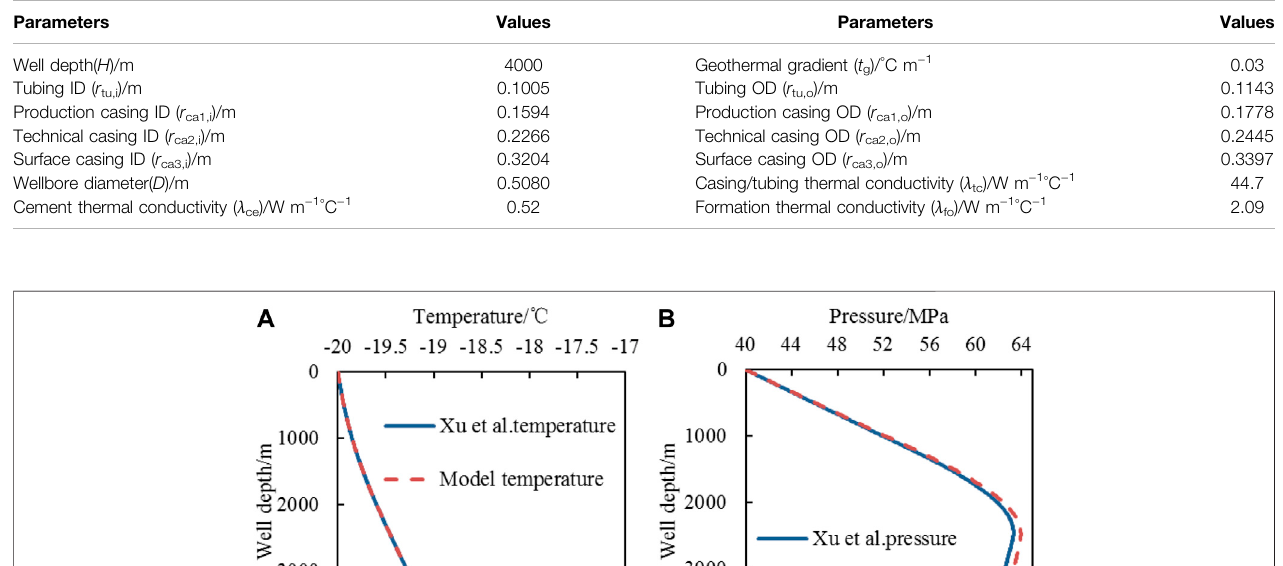
Frontiers in Earth Science |